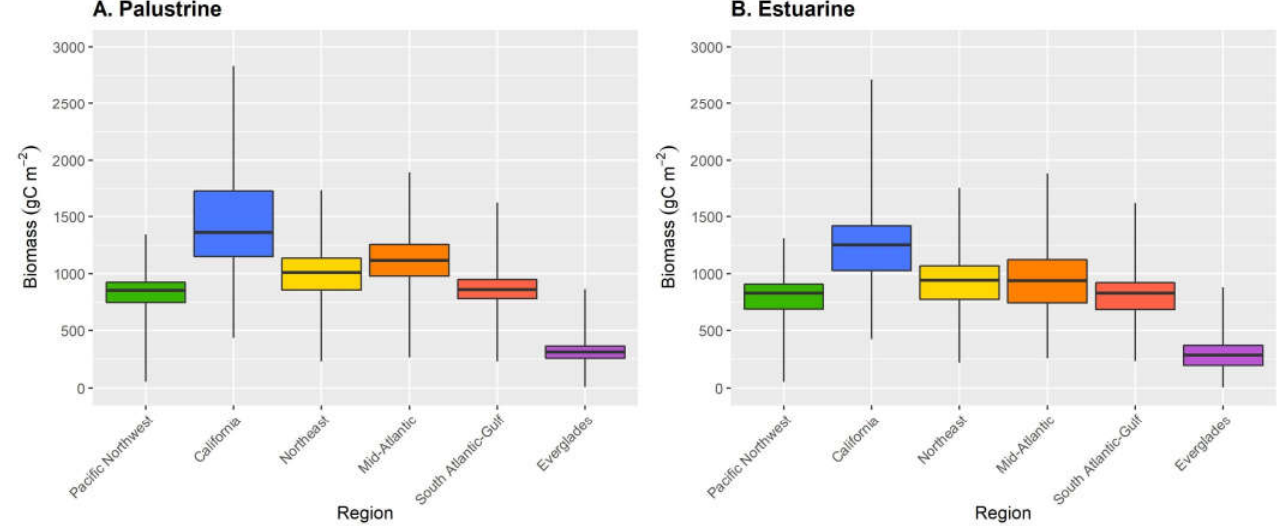
Figure 2. Peak total (above- and belowground) biomass carbon in ( A ) palustrine and ( B ) estuarine herbaceous tidal marshes by region. Box plot boundaries closest to zero represent the 25th percentile, the line within the boxes indicates the median, and boundaries farthest from zero represent the 75th percentile. Table 3. Total tidal marsh area and total (above- and belowground) peak biomass carbon stock for each marsh class, within each region.